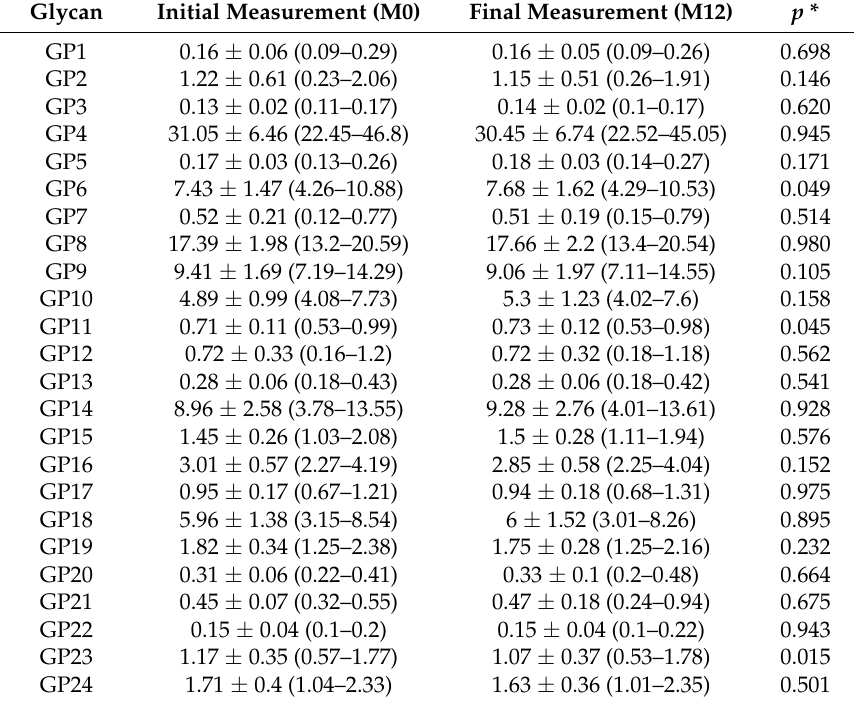
Table 3. Synovial glycan profiles of the initial measurement (M0) vs. final measurement (M12). Glycan